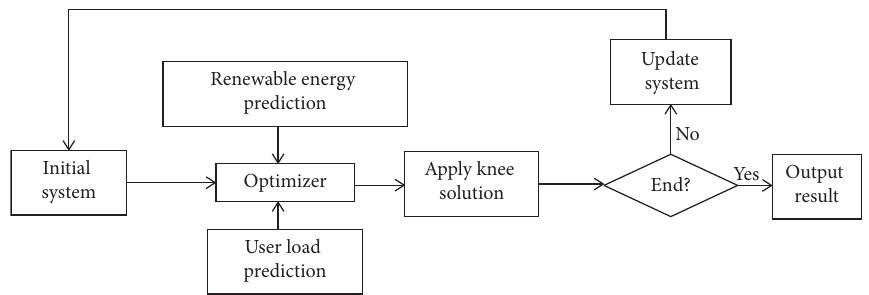
Figure 3: MPC framework optimization flow